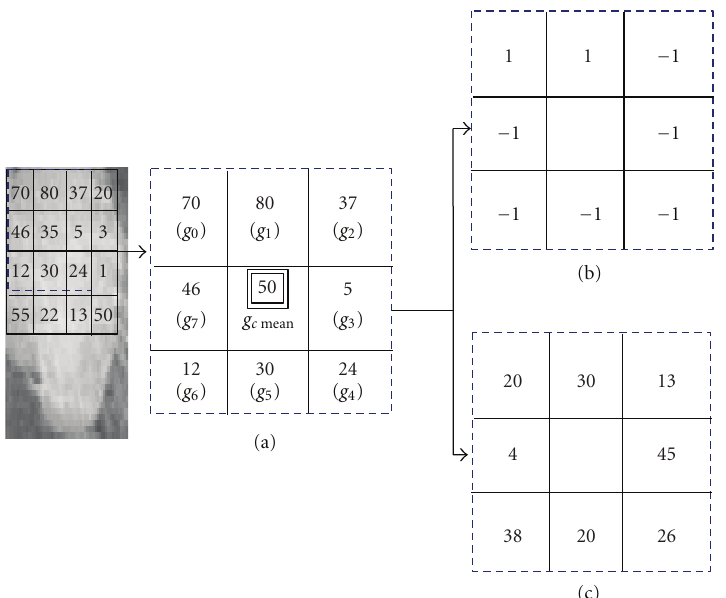
Figure 3: (a) A 3 ∗ 3 block with central pixel corresponding to the mean value of its neighbors. (b) The sign components. (c) The magnitude components.